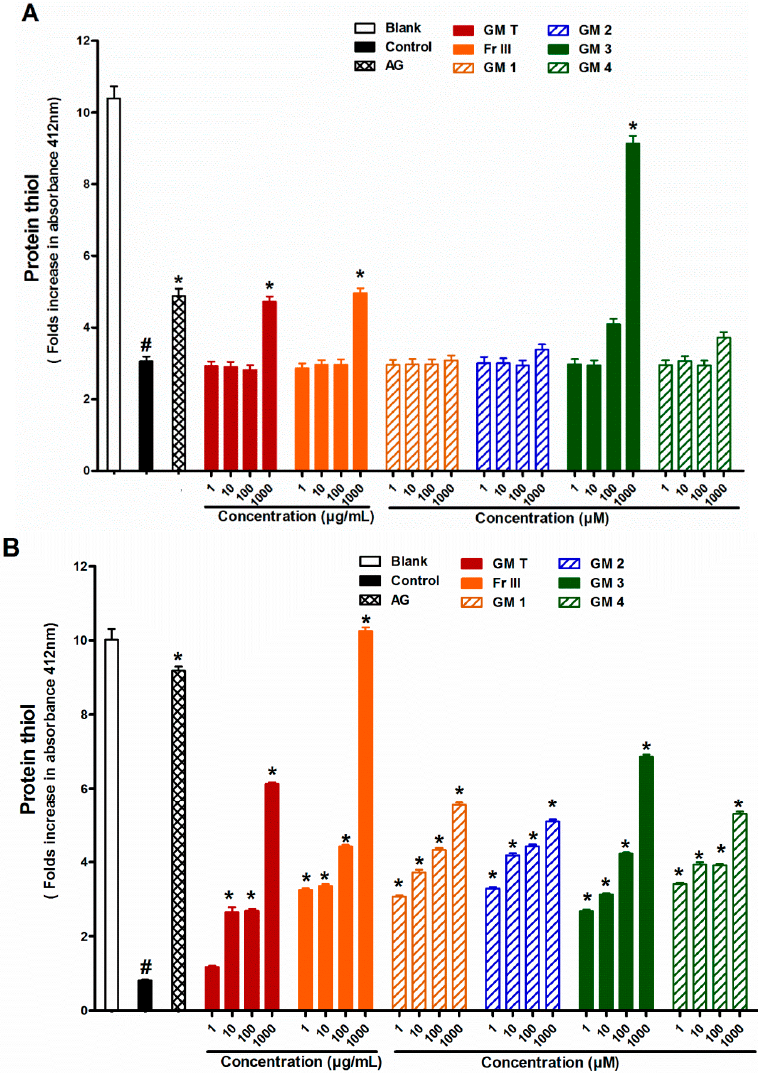
Figure 6. Effect of GMT, Fr III and isolated compounds on protein thiol levels when BSA incubated with glucose ( A ), and ribose ( B ) at week 4. Blank is a reaction mixture including BSA and glucose or ribose kept at − 20 °C while control is the same reaction mixture but incubated at 37 °C. AG was used as standard anti AGEs drug. Results are expressed as mean ± SEM ( n = 3). # p < 0.05 when compared to Blank, * p < 0.05 when compared to Control.